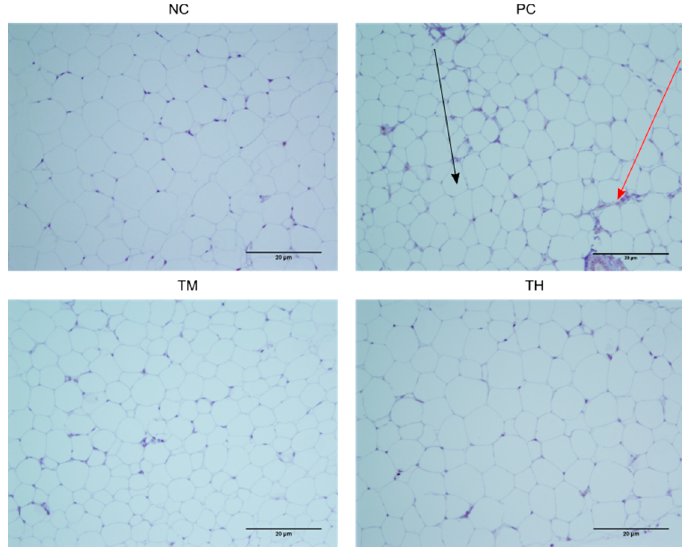
Figure 6. F4/80 stained immune-histochemical images of white adipose tissue. The black arrow indicates an adipocyte, while the red arrow indicates the brown-stained crown-like structure of the site of macrophage infiltration. For PC, n = 4 samples, and for NC, TM, and TH, n = 4 samples had slides made.